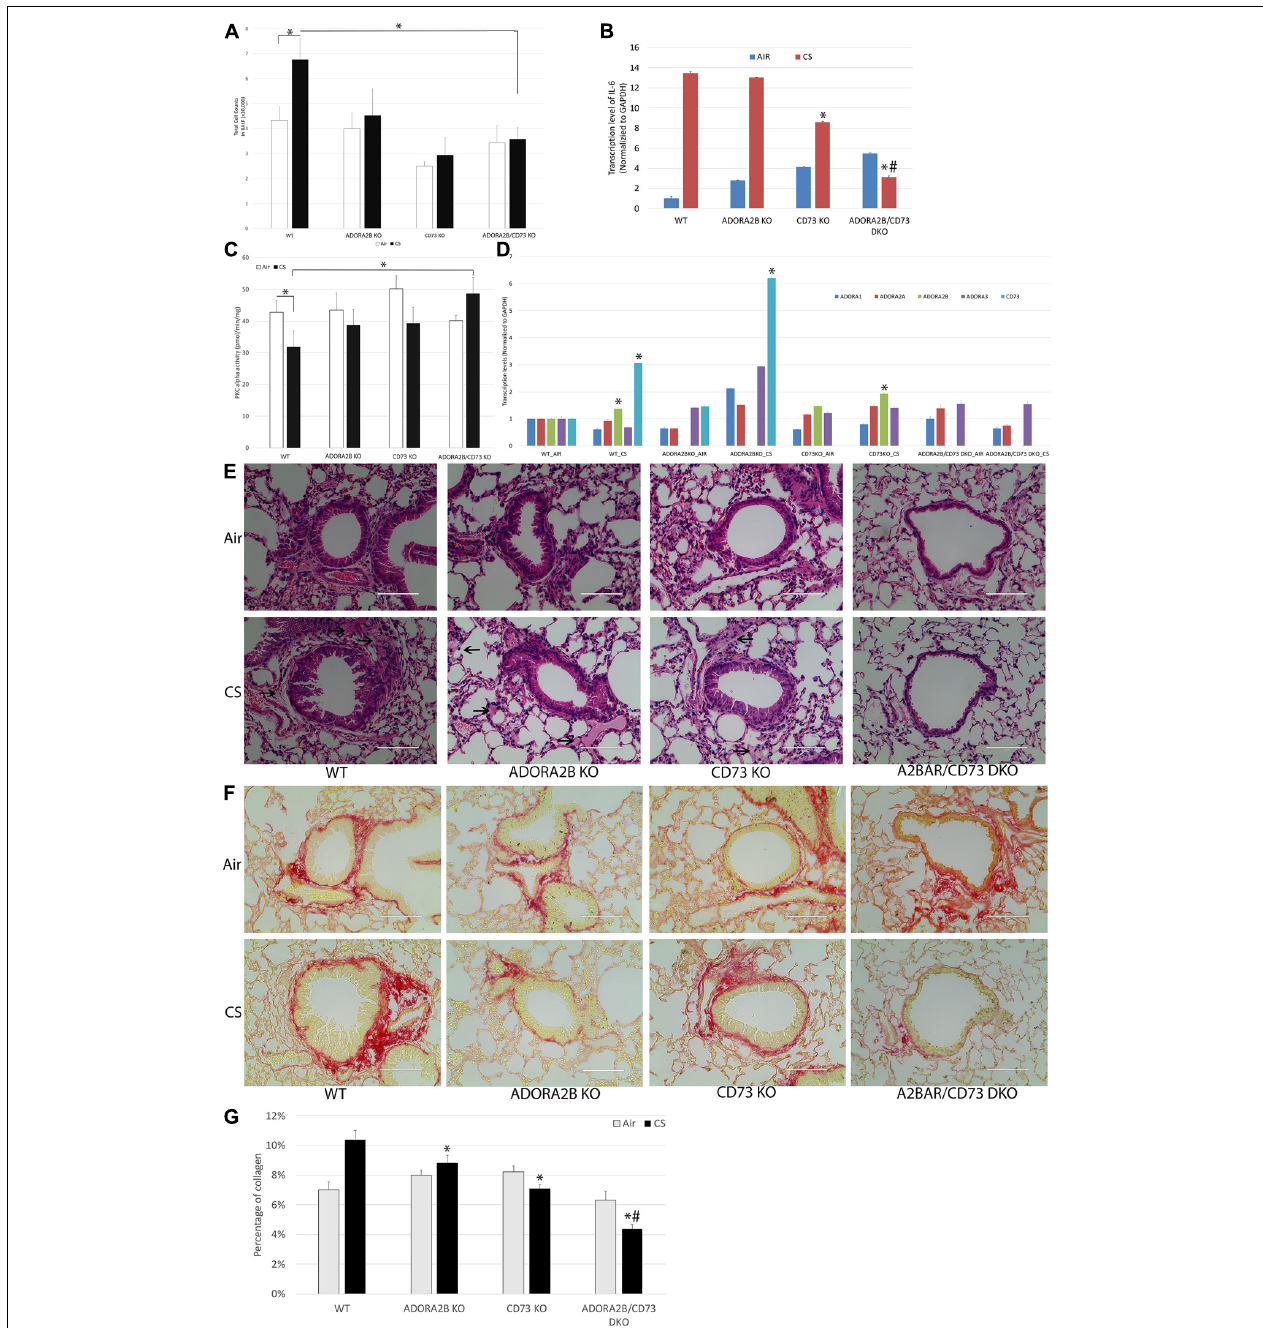
FIGURE 6 | Double knockout CD73 and ADORA2B improves CS-induced lung injury. (A) CD73/ADORA2B DKO decreases CS-induced inflammatory cells in BALF. Data are mean ± SE, ∗ indicated p < 0.05. n = 6. (B) Transcript levels of IL-6 in mice. ∗ indicates significance value P < 0.05 compared with WT mice. # indicates significance value P < 0.05 compared with ADORA2B KO and CD73 KO mice. (C) CD73/ADORA2B DKO activates chronic CS treatment inhibited PKC alpha. Data are mean ± SE, ∗ indicated p < 0.05. n = 6. (D) Transcript levels of ADORA1, ADORA2A, ADORA2B, ADORA3, and CD73 in mice. ∗ indicates significance value P < 0.05 compared with their AIR control group. (E) Photomicrographs of representative histopathological profiles. Sections of mouse lung tissue were paraffin-embedded and stained with hematoxylin and eosin in each cohort. Arrows show fibrosis-like changes comprised of connective tissue and extracellular matrix present in samples. Scale bar, 100 µ m. (F) Representative micrograph of lung sections from different groups of mice. Sections were stained with Picro-Sirius Red Solution (collagen was highlighted as red color, muscle fibers and cytoplasm were highlighted as yellow). Scale bar, 100 µ m. (G) Quantitative analysis of lung collagen contents by ImageJ were expressed as Mean ± SD. ∗ indicated p < 0.05 compared with WT-CS group. # indicated p < 0.05 compared with ADORA2B KO and CD73 KO mice. More abundant collagen is accumulated in CS-treated WT mice as compared to WT control mice, and double knockout ADORA2B and CD73 dramatically reduced collagen